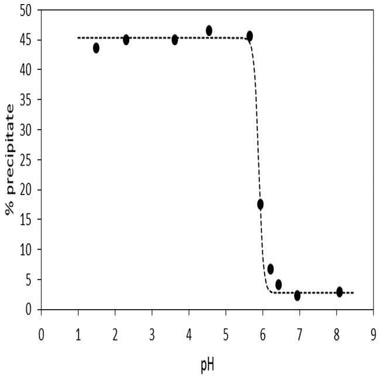
Percentage of precipitate with respect to the total dry matter content formed as a function of pH; dashed line is intended as visual aid only.